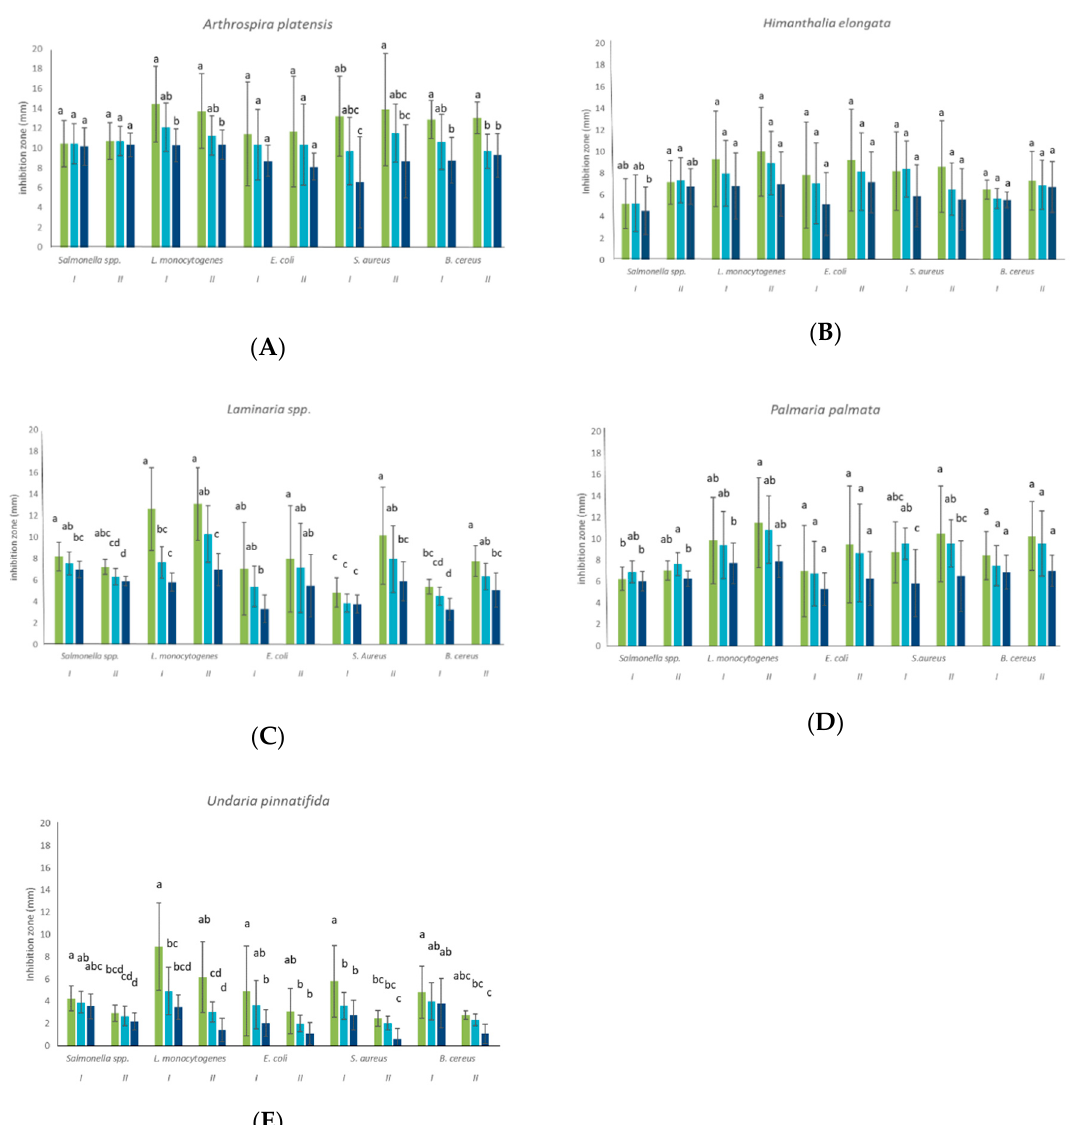
Figure 2. Antimicrobial activity of algae extracts along time: 24 h (Green line), 48 h (light blue line) and 120 h (Blue line). ( A ) Arthrospira platensis extracts; ( B ) Himanthalia elongata extracts. ( C ) Laminaria spp. extracts. ( D ) Palmaria palmata extracts. ( E ) Undaria pinnatifida extracts. The means with different letters are significantly different ( p < 0.05).